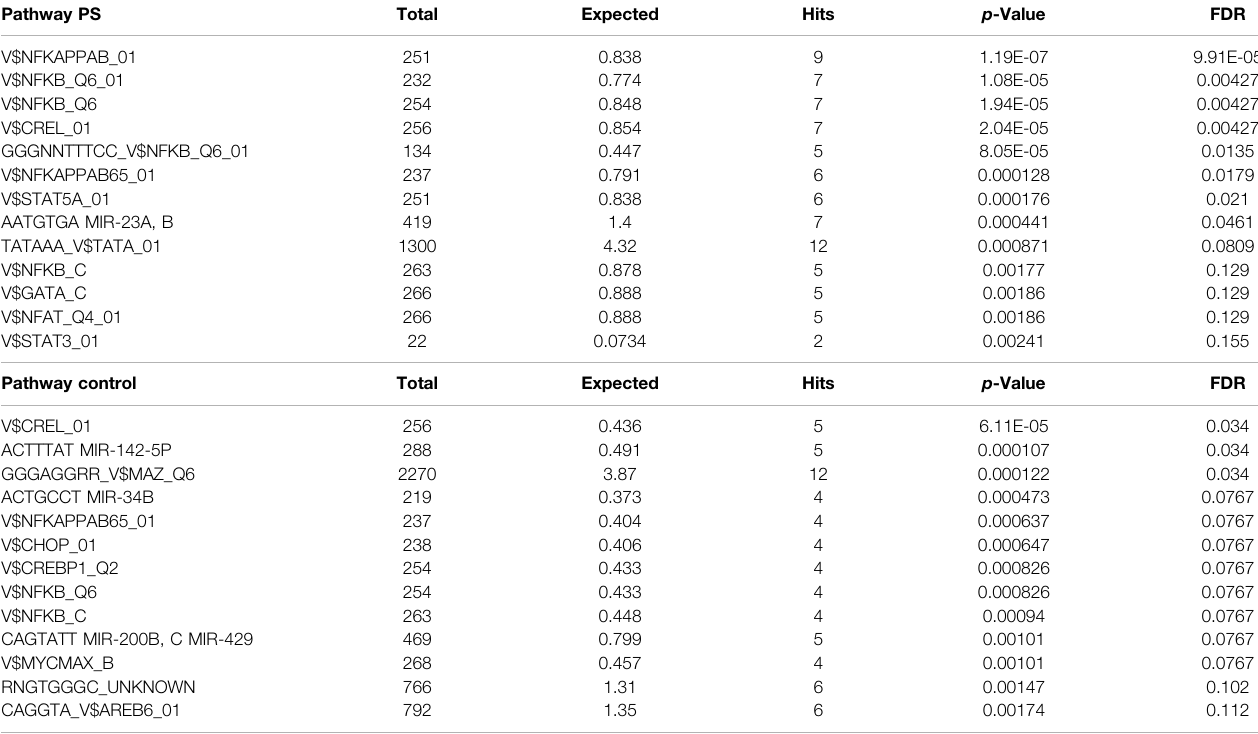
TABLE 1 | Analysis of potential PS-responsive transcription factors and microRNAs. Pathway